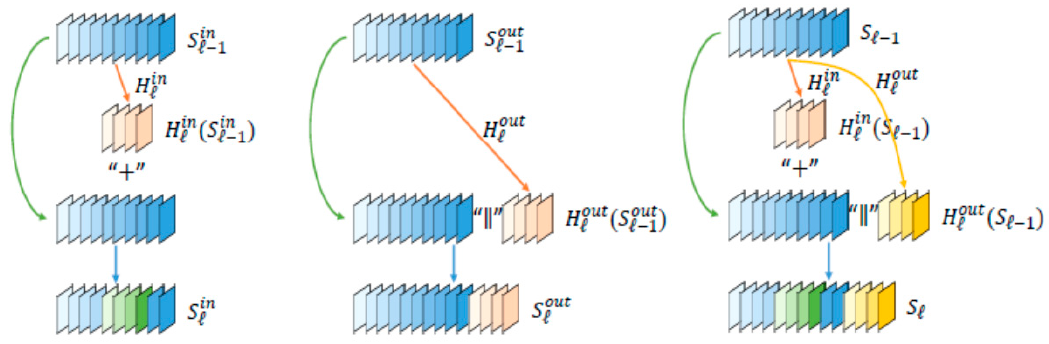
Figure 5. Inner link module ( left ), outer link module ( middle ), and mixed inner–outer module ( right ).